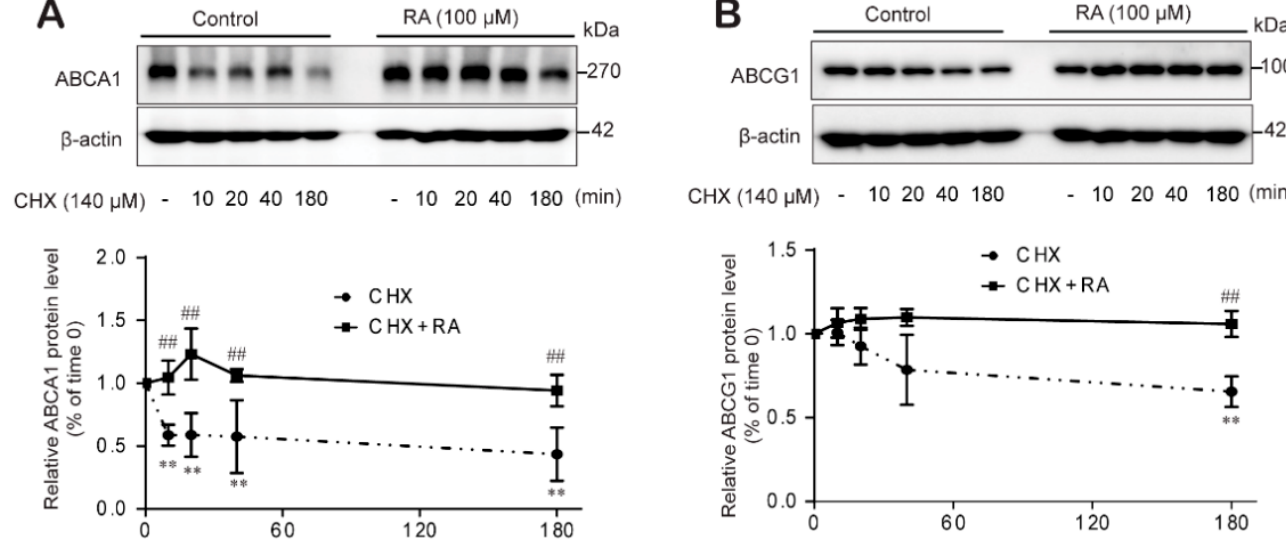
Figure 6. RA stabilizes ABCA1 protein levels by impairing protein degradation. THP-1 macrophages were incubated for 24 h with or without RA (100 μ M) and treated with CHX (140 μ M) for different durations (0, 10, 20, 40 and 180 min). Cell lysates were collected to analyze ABCA1 ( A ) and ABCG1 protein levels ( B ) by western blot analysis. Band densities were quantified, and relative protein levels are presented as the mean ± SD of five independent experiments. Significance is indicated by ** p < 0.01 compared with the control; ## p < 0.01 compared to the CHK-treated group. ( C – E ) Cells were treated with or without RA at 100 μ M for 24 h and incubated for another 3 h with the lysosomal inhibitor chloroquine (CHQ, 100 μ M) ( C ), the proteasome inhibitor lactacystin (LAT, 10 μ M) ( D ), or the calpain inhibitor calpeptin (CAL, 30 μ g/mL) ( E ). Cell lysates were collected for ABCA1 and ABCG1 protein analysis using western blot analysis. Band densities were quan- tified, and relative protein levels are presented as the mean ± SD of five independent experiments. ** p < 0.01 compared to the control; ## p < 0.01 compared to the CAL-treated group.